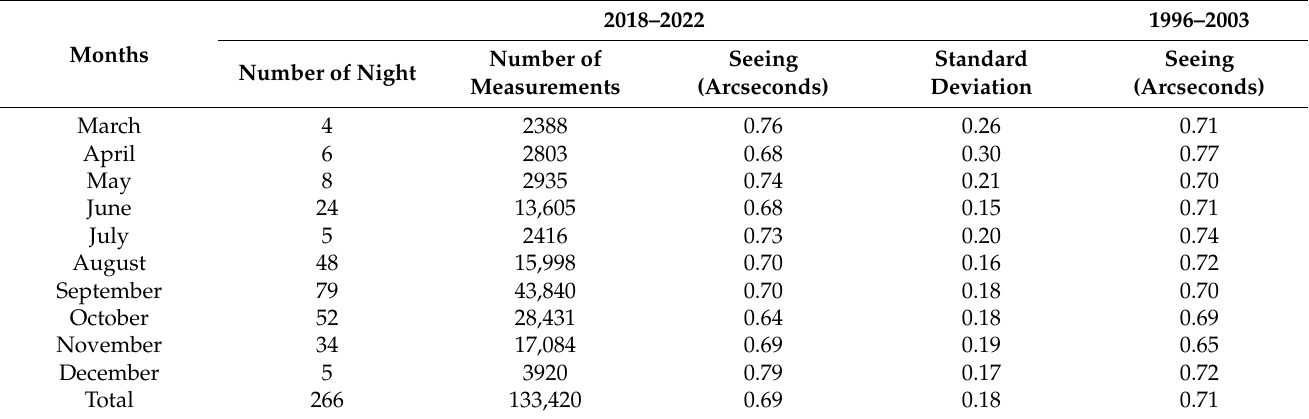
Table 2. Monthly seeing statistics for 2018 – 2022 and 1996 – 2003.